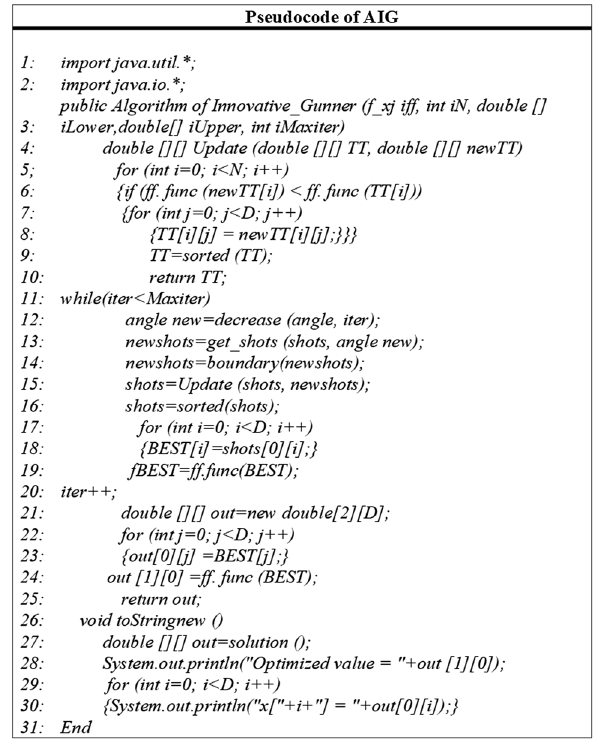
Fig. 3 Pseudocode of AIG algorithm (Roshni et al. 2022)